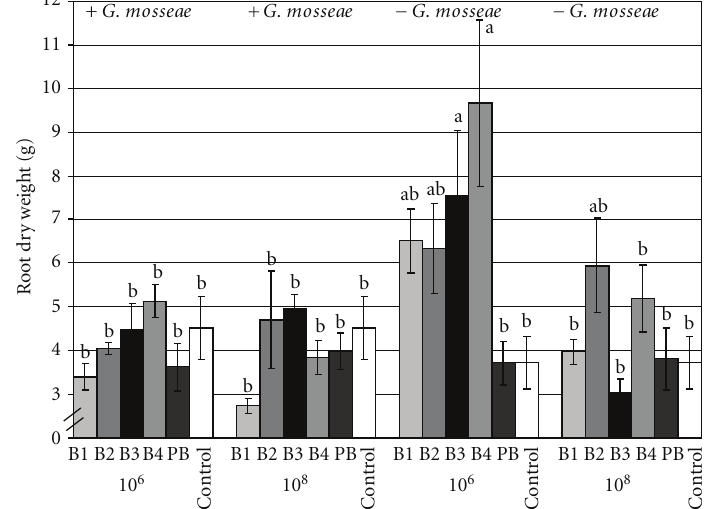
Figure 2: Average dry weight of roots at harvest (15 weeks) from wheat plants inoculated with G. mosseae and/or di ff erent paenibacilli strains (B1–B4 and PB177) at concentrations of 10 6 or 10 8 bacterial cells 10 g − 1 of seeds or left untreated. The same letters above the bars indicate treatments with no significant di ff erences ( P > . 05). Error bars represent the standard error of the mean.